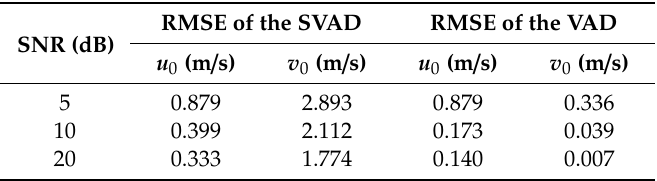
Table 6. Performance comparison between the SVAD and VAD, for linear wind field. RMSE of the SVAD RMSE of the VAD SNR (dB) u 0 (m / s) v 0 (m / s) u 0 (m / s) v 0 (m /